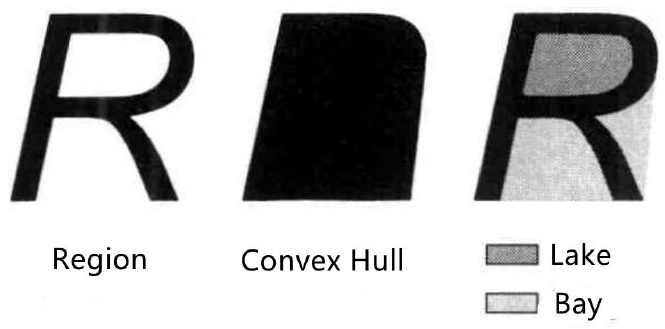
Figure 6. Object “R”, its convex hull and its associated lakes and bays.